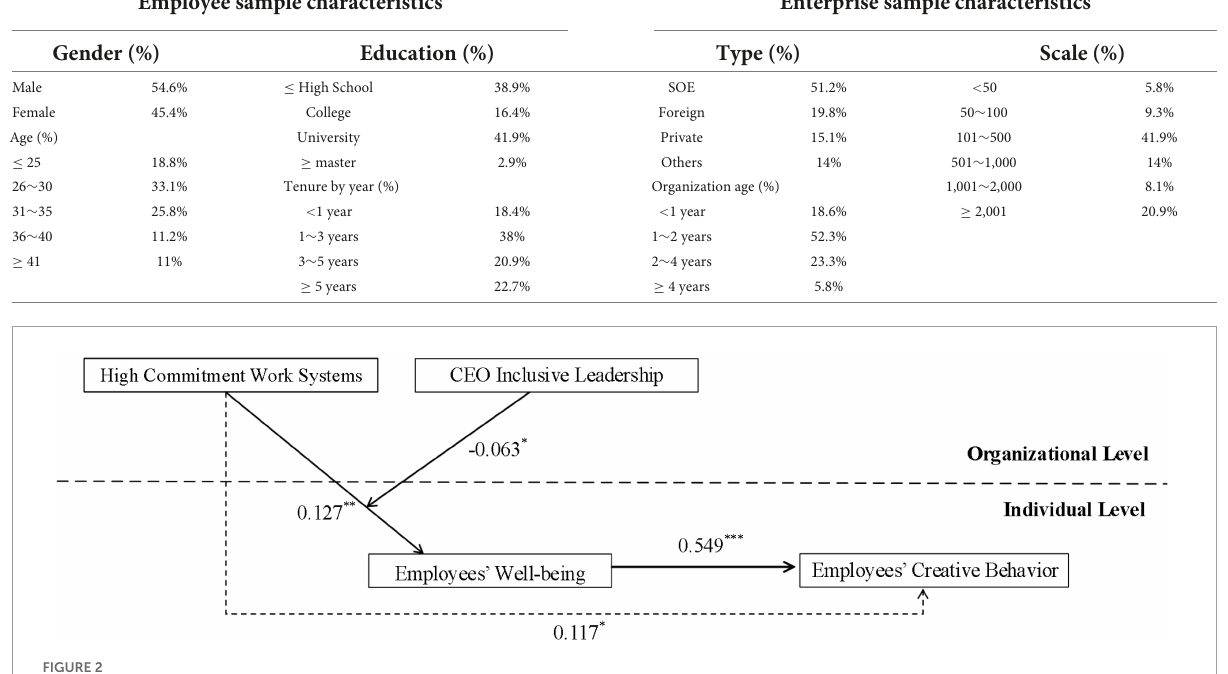
FIGURE2 Multilevel SEM model path analysis. ∗∗∗ p < 0.001 ∗∗ p < 0.01, ∗ p < 0.05.